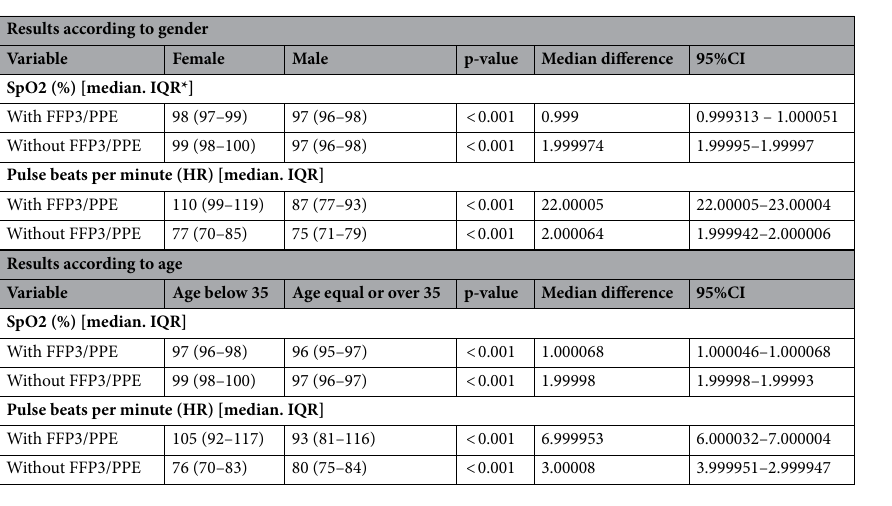
Table 1. The results of blood saturation and heart rate in HCWs wearing the FFP3/PPE with a breakdown based on sex and age. *Interquartile